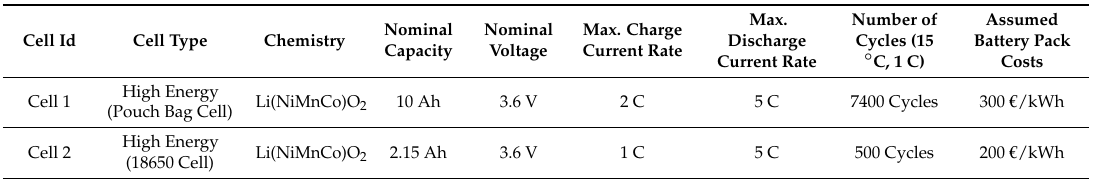
Table 2. Technical data of cells contained in the electric cell model and assumed costs of battery pack containing the particular cell